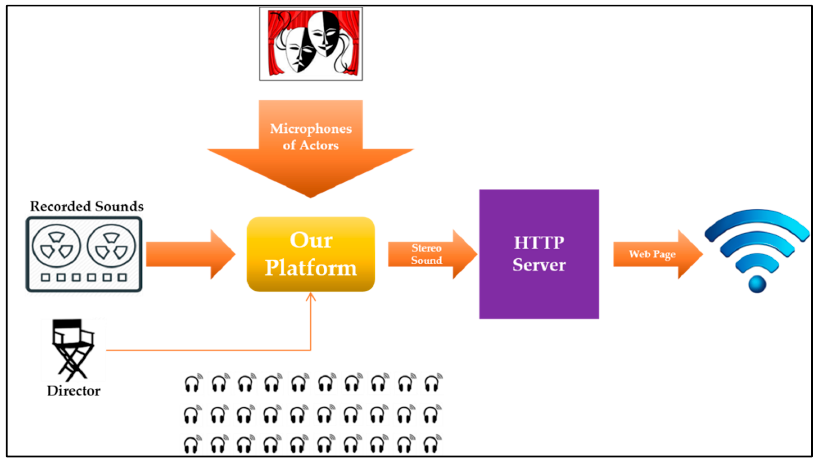
Figure 8. Use case scenario 3 — spatial/personalized sound with cohearing of the audience through personal